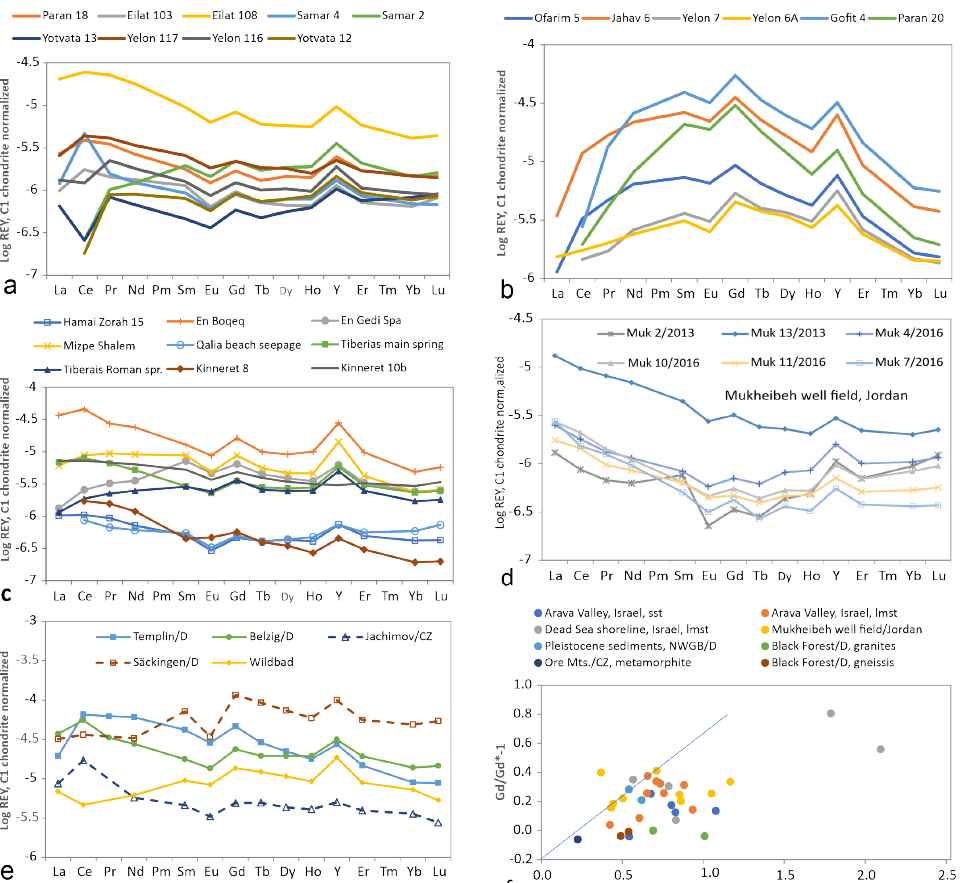
Figure 9. Thermosaline groundwater. C1 chondrite-normalized rare earths and Y distribution patterns of ( a ) saline waters from limestones of the Arava Valley, Israel [65]; ( b ) saline waters from Nubian sandstones in the Arava Valley/Negev, Israel [83]; ( c ) brines from wells along Lake Tiberias and the Dead Sea, Israel [75]; ( d ) Groundwater from limestones in the Mukheibeh well field, Yarmouk Gorge, Jordan [53]; ( e ) well water from the Quaternary sediments in the North-Western German Basin [79]. ( f ) Correlation of Gd and Y anomalies. The slopes scatter between 0 and